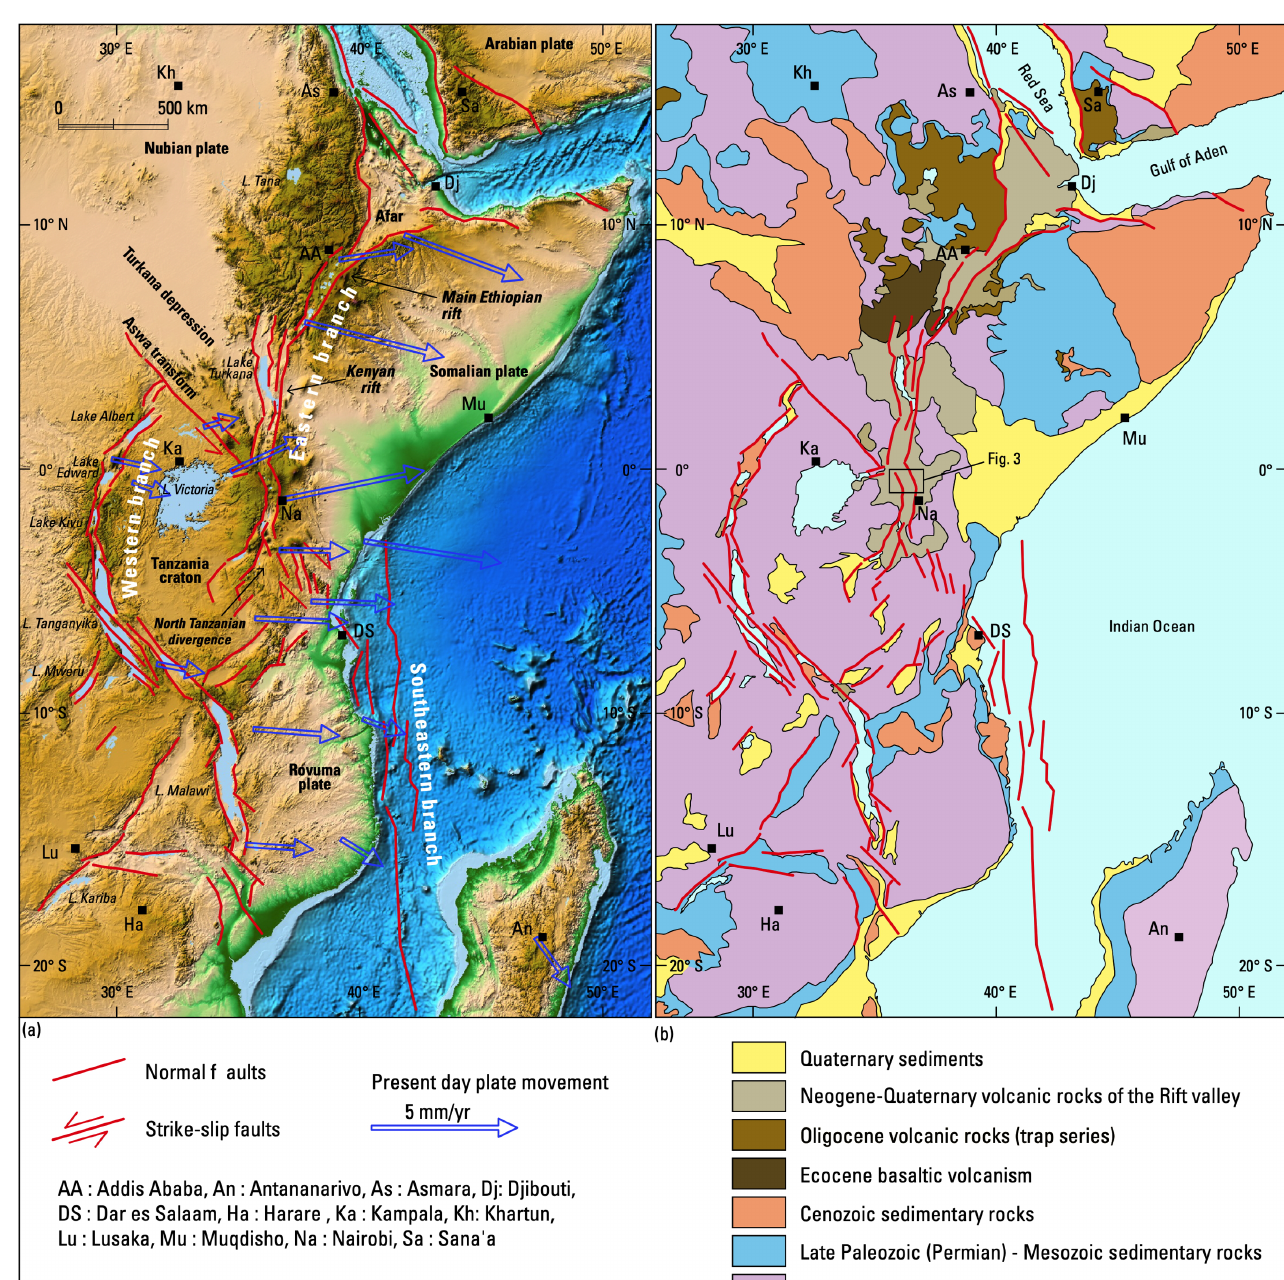
Figure 1. ( a ) Main tectonic features of the East African Rift System, after Chorowicz [1], background image by NOAA [12]. Present day plate movement after Saria et al. [4] (Nubian plate fixed). ( b ) Geological map, after Persits et al. [13], Geological Survey of Ethiopia [14], Geological Survey of Tanzania [15] and Schlüter